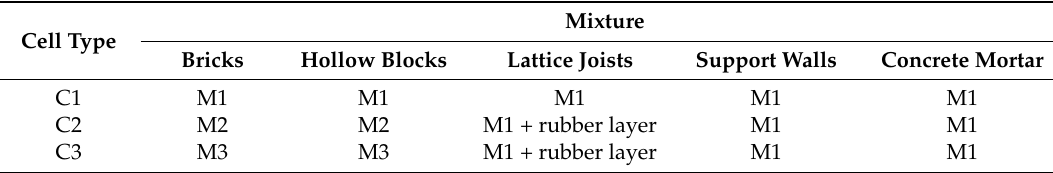
Table 2. Composition of the building